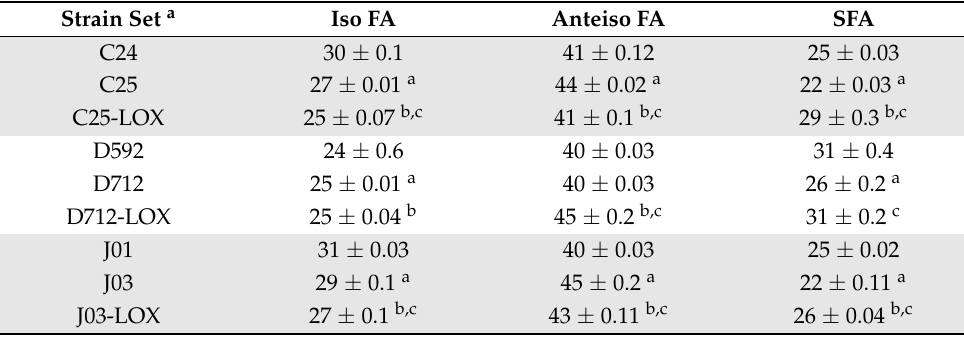
Table 4. Fatty acids (%) composition of LOX passaged strain vs. DAP-R/DAP-S. Strain Set